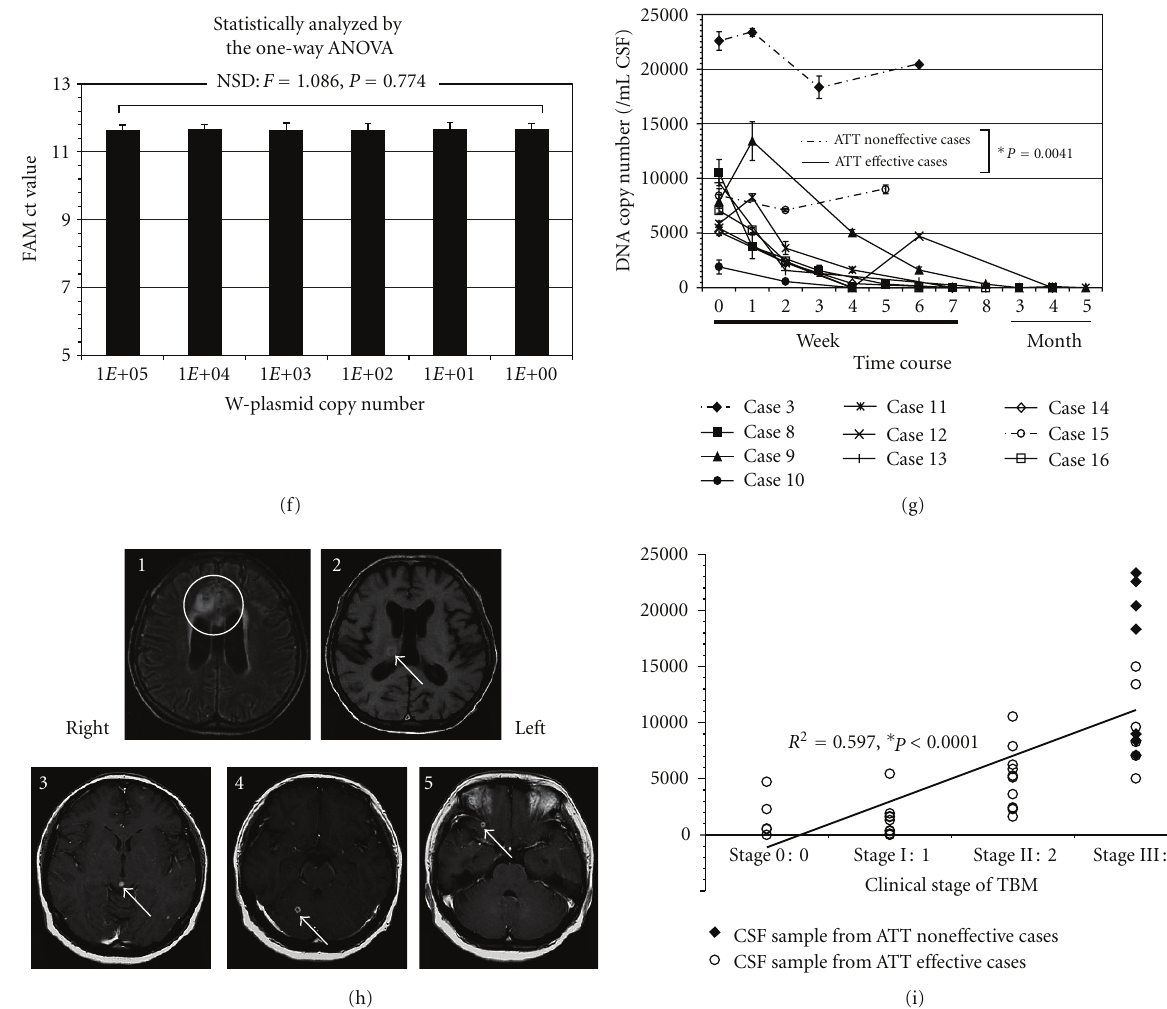
Figure 2: The principle of wide-range (WR) quantitative nested real-time (QNRT) PCR assay and its results. (a) A schema indicating